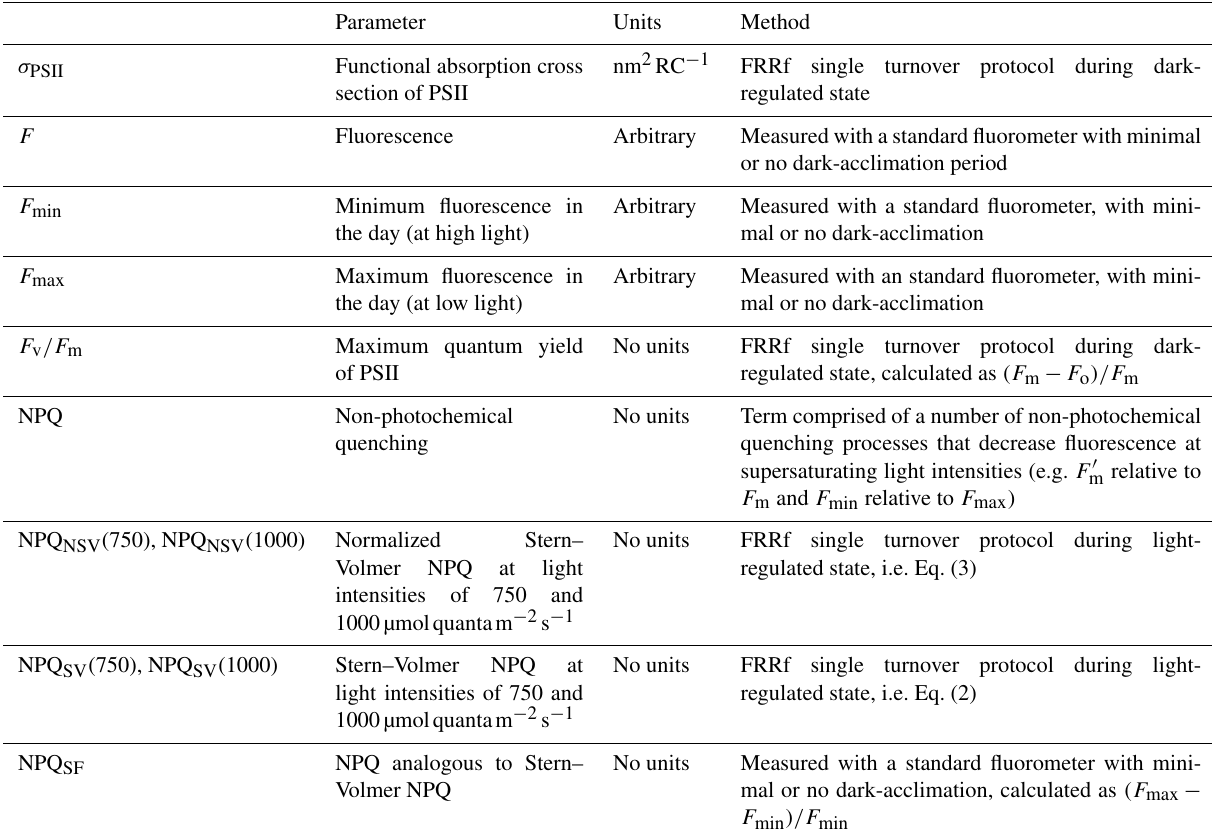
Table 2. List of fluorescence-related parameters derived and discussed. Parameter